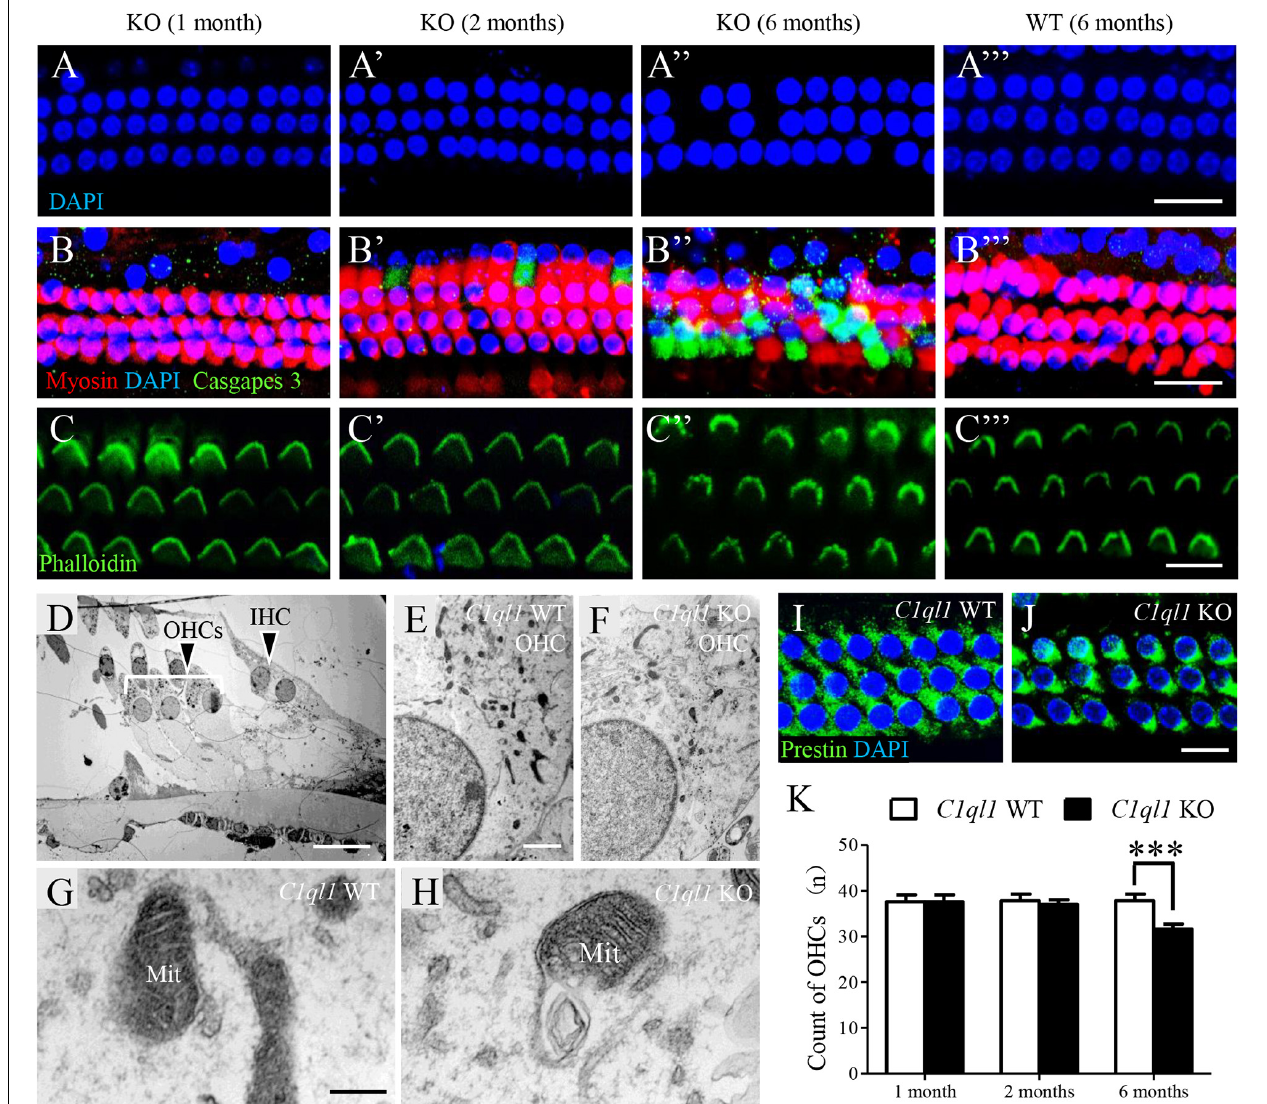
FIGURE 8 | Morphology of cochlear outer hair cells in C1ql1 WT mice and C1ql1 KO mice. (A–C) Outer hair cells showed by immunofluorescence staining in C1ql1 KO mice (postnatal 30 and 60 days, and 6 months, respectively) and in C1ql1 WT mice (postnatal 6 months, as control group). Scale bar = 10 µ m. (A–A (cid:48)(cid:48)(cid:48) ) The nucleus (blue, labeled by DAPI) of outer hair cells in groups aforementioned. (B–B (cid:48)(cid:48)(cid:48) ) The apoptotic signal (green, labeled by caspase 9) of outer hair cells in groups aforementioned. (C–C (cid:48)(cid:48)(cid:48) ) The stereocilia of outer hair cells (green, labeled by phalloidin) in groups aforementioned. (D) Subcellular structures of outer hair cells in mice. Scale bar = 5 µ m. (E,F) Much more mitochondria have been observed being swallowed by phagosomes in C1ql1 KO mice than C1ql1 WT mice. (G,H) Mitochondria in C1ql1 WT mice and C1ql1 KO mice. (I,J) Prestin in C1ql1 WT mice and C1ql1 KO mice. Scale bar = 10 µ m. (K) Count of OHCs in C1ql1 WT mice and C1ql1 KO mice in postnatal 1 and 6 months. ∗∗∗ P <